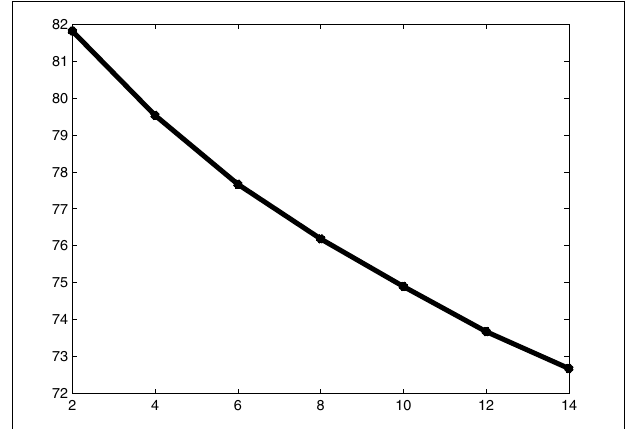
FIGURE 7 | Average of the lengths of estimated 95% predictive intervals, when adding up to 14 design locations.